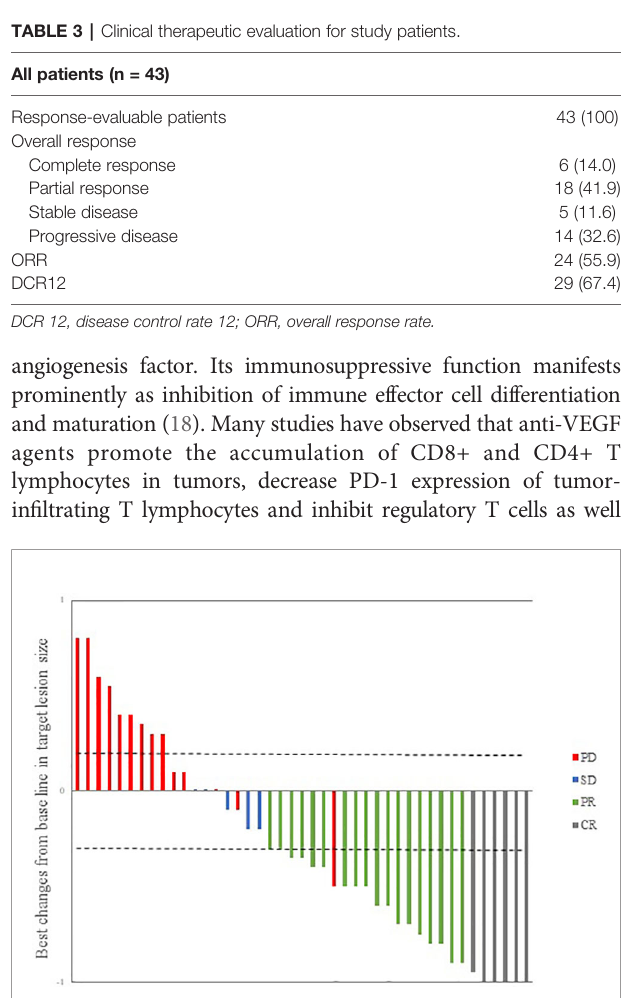
FIGURE 4 | Kaplan-Meier survival curve of progression-free survival in ECOG PS 0 and PS 1 patients. PFS, progression-free survival;ECOG PS, Eastern Cooperative Oncology Group performance status; CI, con fi dence interval.